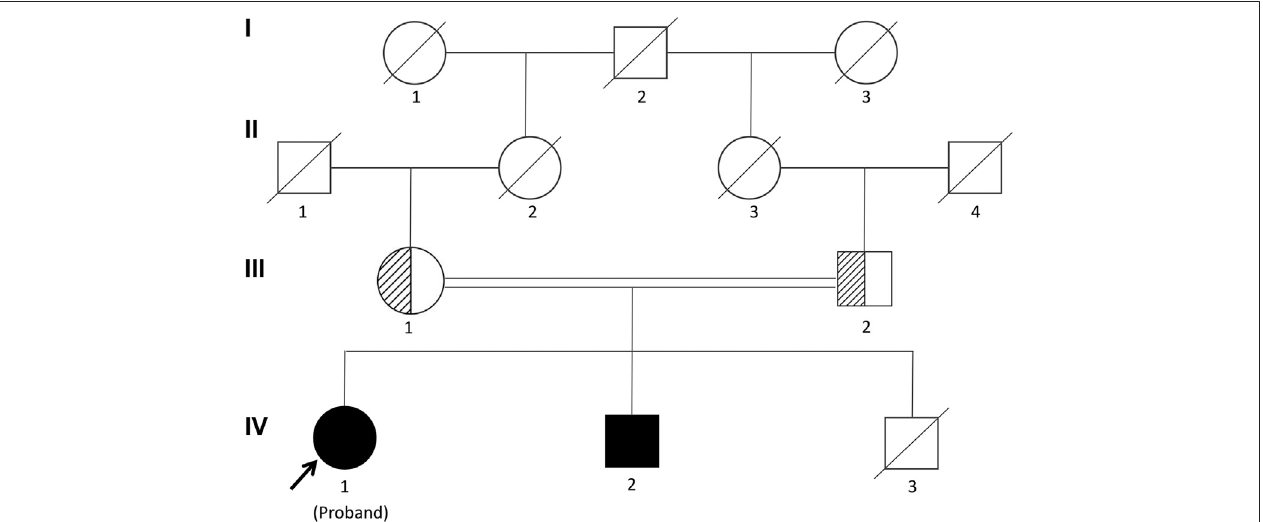
FIGURE 1 | Pedigree of the Chinese family segregating Woodhouse-Sakati syndrome (WSS) in an autosomal recessive manner. Male individuals are represented by squares, and females are represented by circles. Half- fi lled symbols represent a DCAF17 heterozygous mutation, while fi lled symbols represent a DCAF17 homozygous mutation. The third child of the patient ’ s parents died at 7 mo and his genetic analyses could not be investigated.